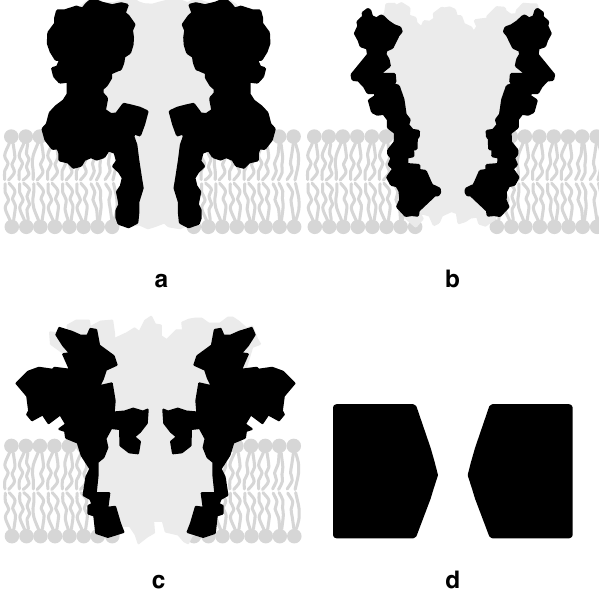
Figure 6. Cross-section of ( a ) the α -HL nanopore infused in a lipid bilayer membrane support structure, ( b ) MspA nanopore, ( c ) CsgG nanopore and ( d ) solid-state